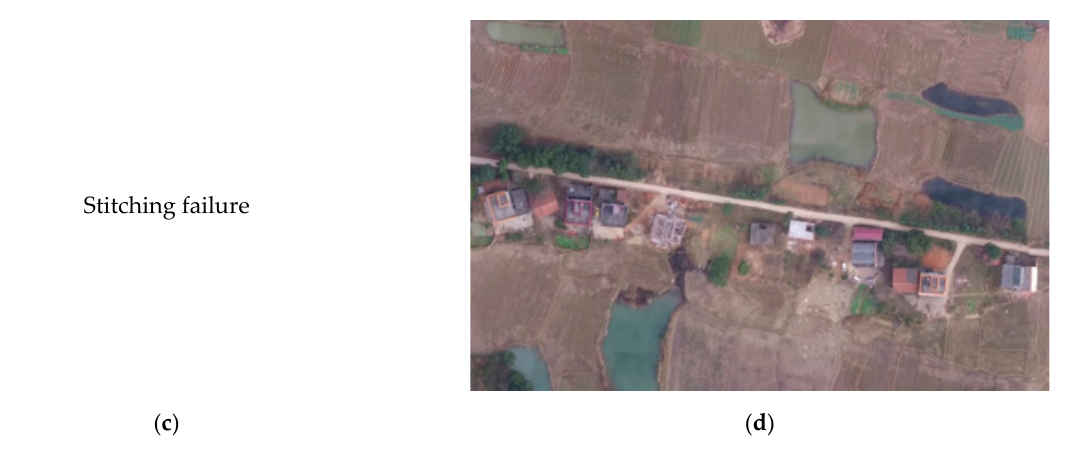
Figure 17. Comparison of road in panorama using different methods. ( a ) QuickBird. ( b ) AutoPano. ( c ) Opencv-Stitcher. ( d ) Our method.